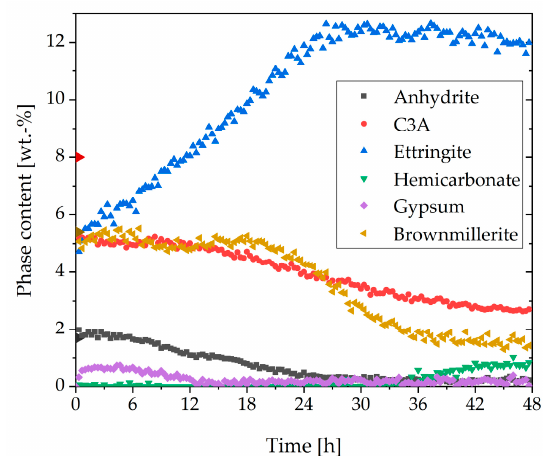
Figure 2. Phase development of the aluminum-containing phases of CEM I during 48 h after water addition (w / c = 0.36).